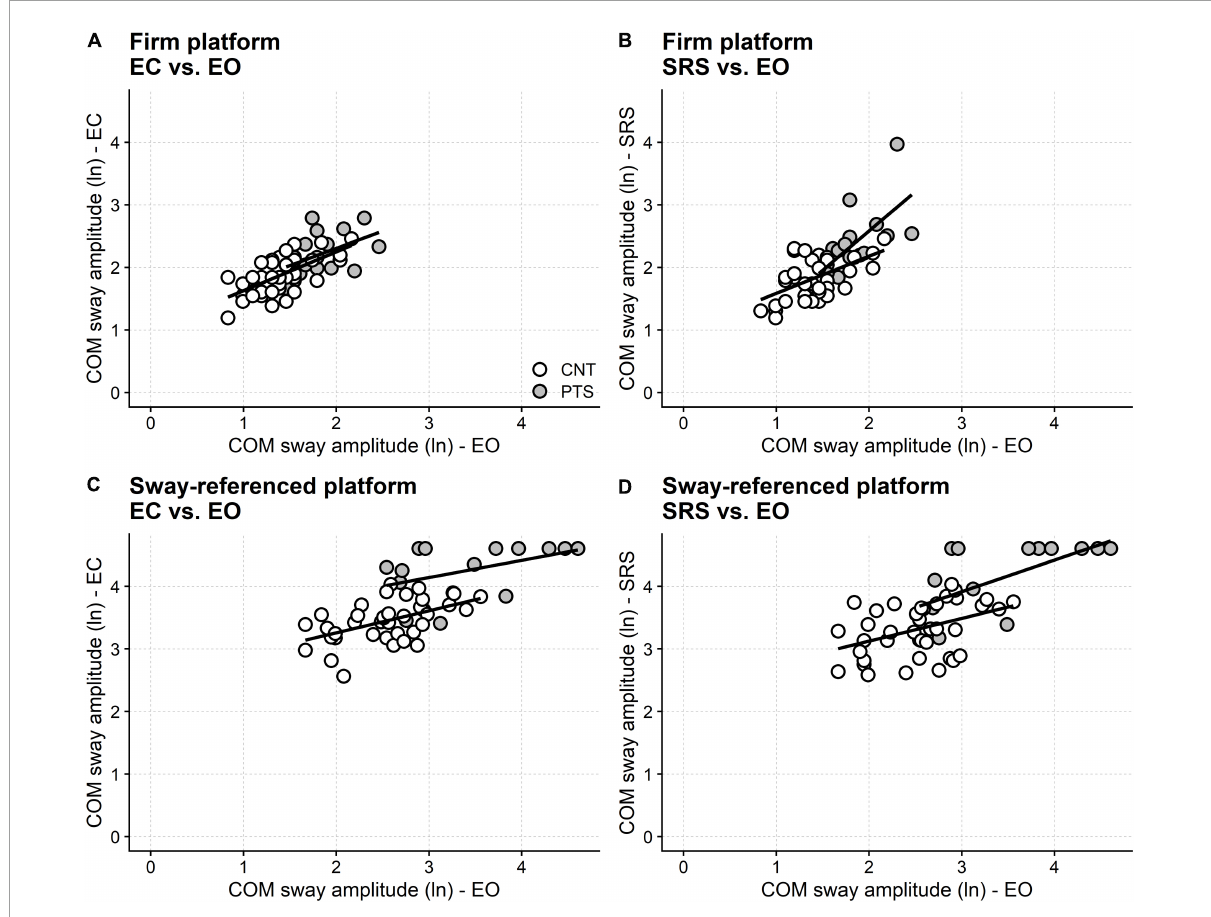
FIGURE4 Visual dependence in DM1. Results from the SOT test. The abscissa gives the subjects sway (natural logarithm, ln, of the normalized COM oscillations) with eyes open, both in controls (open circles) and patients (filled circles). The ordinate gives the sway amplitude in different conditions (see panel labeling). Linear regression lines calculated separately for controls (CNT) and patients (PTS) are also shown. Regression predicts that standing with closed eyes (A) and with sway-referenced surround (B) does not differ between patients and controls on firm support. By contrast, given the same performance with the eyes open on the sway referenced platform, patients perform worse than controls with eyes closed (C) and with the sway referenced surround (D) . This finding points out “visual dependence” (i.e., the excessive reliance on visual information in keeping balance) and suggests difficulty using the vestibular or the proprioceptive information for regulating balance, at least in the most challenging conditions. EO, eyes open; EC, eyes closed; SRS, sway-referenced surrounding